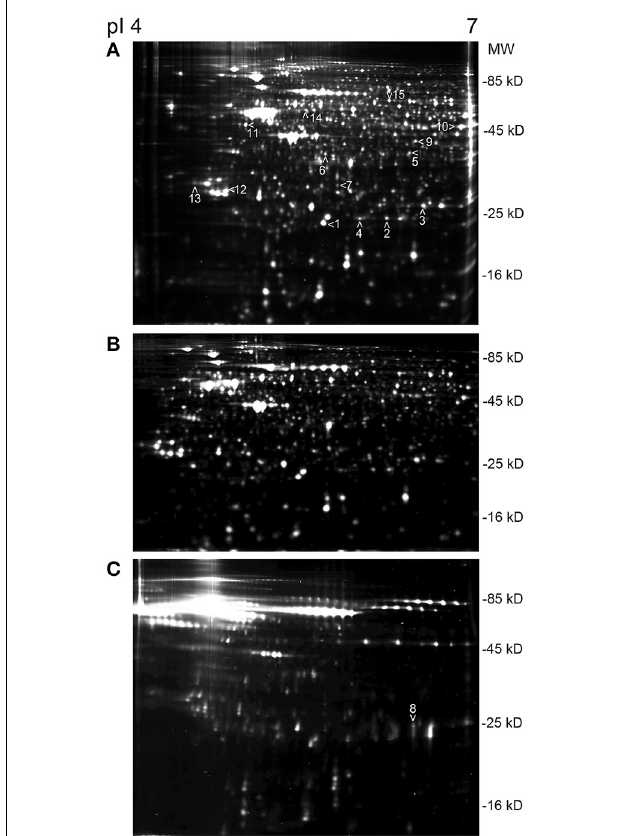
FIGURE 1 | An example sets of 2D-DIGE protein profiles of SH-SY5Y cells. (A) Differentiated SH-SY5Y cells, at the 48h time-point where the number of protein spots was the greatest. The arrow heads indicate the picked proteins, done from the silver stained gels; protein ID: (1) PRX2, (2) PRX3, (3) PRX6, (4) DJ-1, (5) BLVRA, (6) DDAH1, (7) DDAH2, (8) TIMP2, (9) SEPT2, (10) ENOA, (11) ENOG, (12) 14-3-3 γ , (13) 14-3-3 ε , (14) RUFY3, (15) CRMP2. (B) Undifferentiated SH-SY5Y neuroblastoma cells showed the least number of spots, in comparison to differentiated SH-SY5Y cells in (A) . (C) Protein profile of the culture medium of the differentiated SH-SY5Y cells at the 72h time-point. Protein ID 8, TIMP2, was picked from the medium gel. The strip pI range was the same in all shown